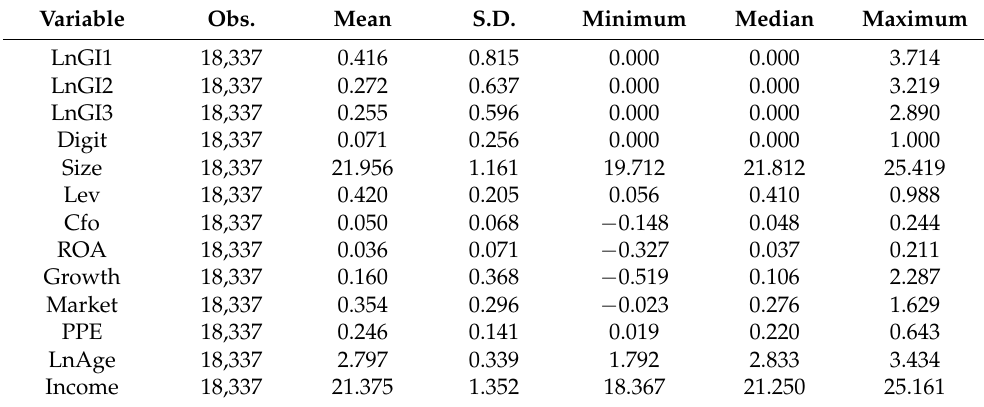
Table 2. Summary